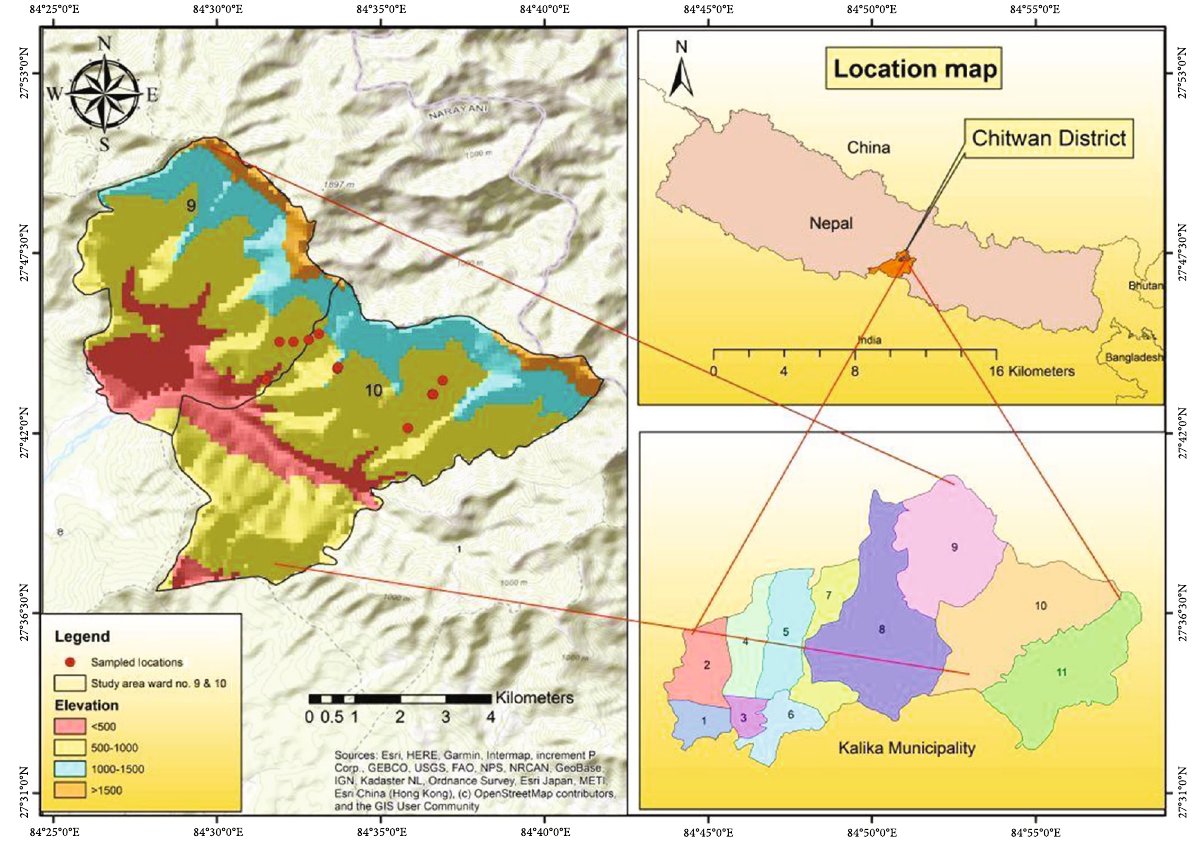
Figure 1: Map of the study area showing the locations of sample